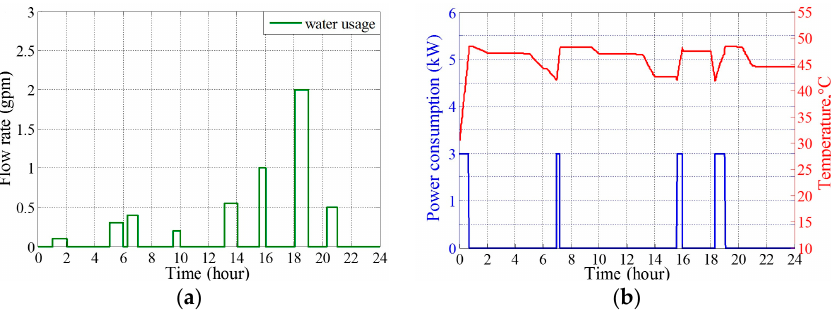
Figure 16. Simulation model of EWH load: ( a ) flow rate of the hot water in gpm; and ( b ) hot water temperature within 42–48 °C with the power consumption pattern.